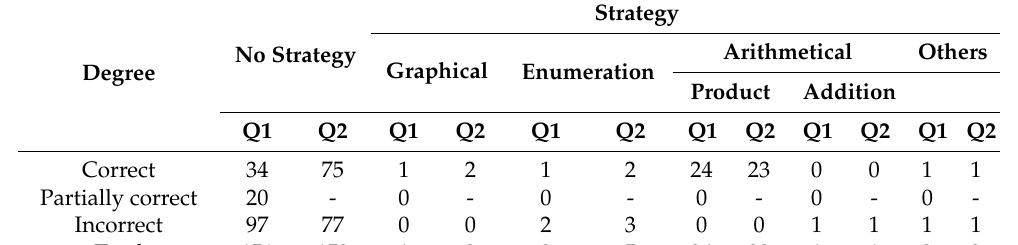
Table 3. Degree-strategy frequencies of Q1 and Q2.